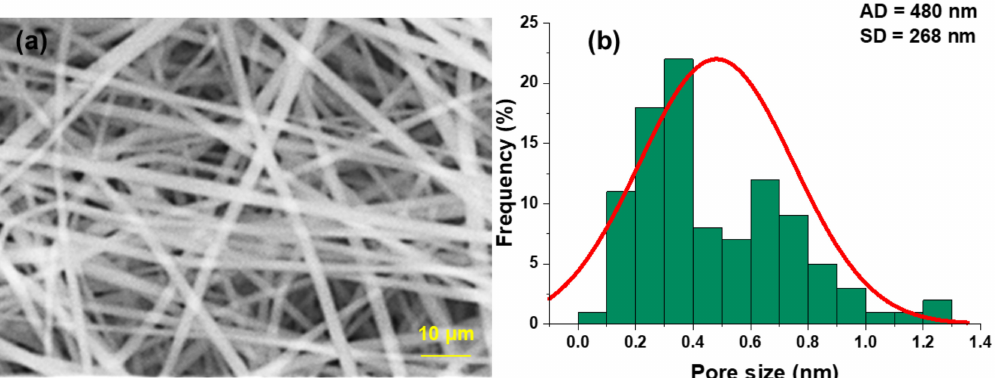
Figure 5. SEM morphology and pore size frequency distribution of electrospun composite structure nanofiber membrane. ( a ) SEM image of electrospun composite structure nanofiber membrane; ( b ) Pore size frequency distribution of electrospun composite structure nanofiber